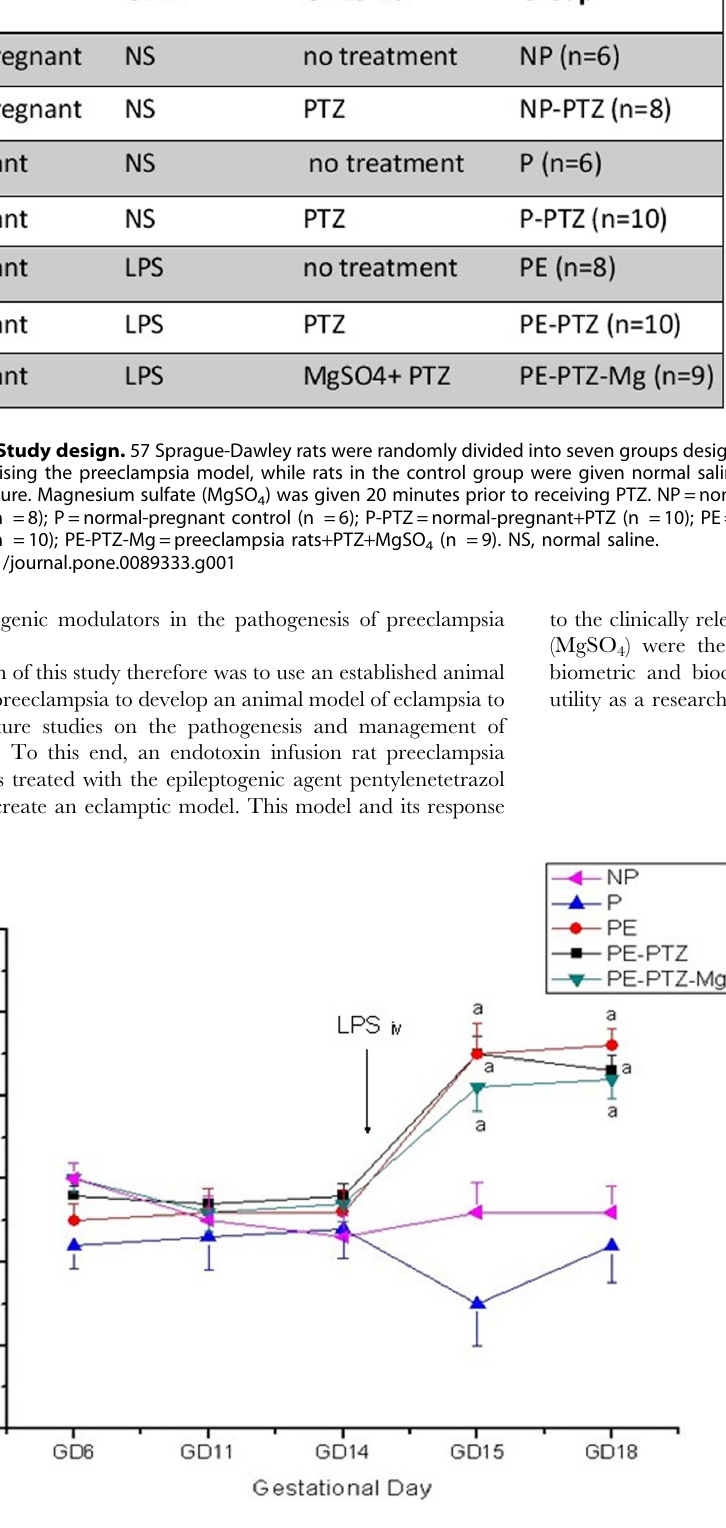
Figure 2. Mean systolic blood pressures of each groups measured before and after endotoxin infusion. Data are expressed as mean 6 SEM of the SBP (mmHg)(repeated measures analysis of variance). NP, non-pregnant rats; P, pregnant rats; PE, preeclamptic rats. SBP was measured on GDs 6, 11, 14, 15, and 18 in pregnant groups and on corresponding days in NP group. (a) P , 0.01, PE, PE-PTZ and PE-PTZ-Mg group on GDs 15 and 18, compared with NP and P group on the corresponding GDs and prior to the infusion of LPS on GD 14.